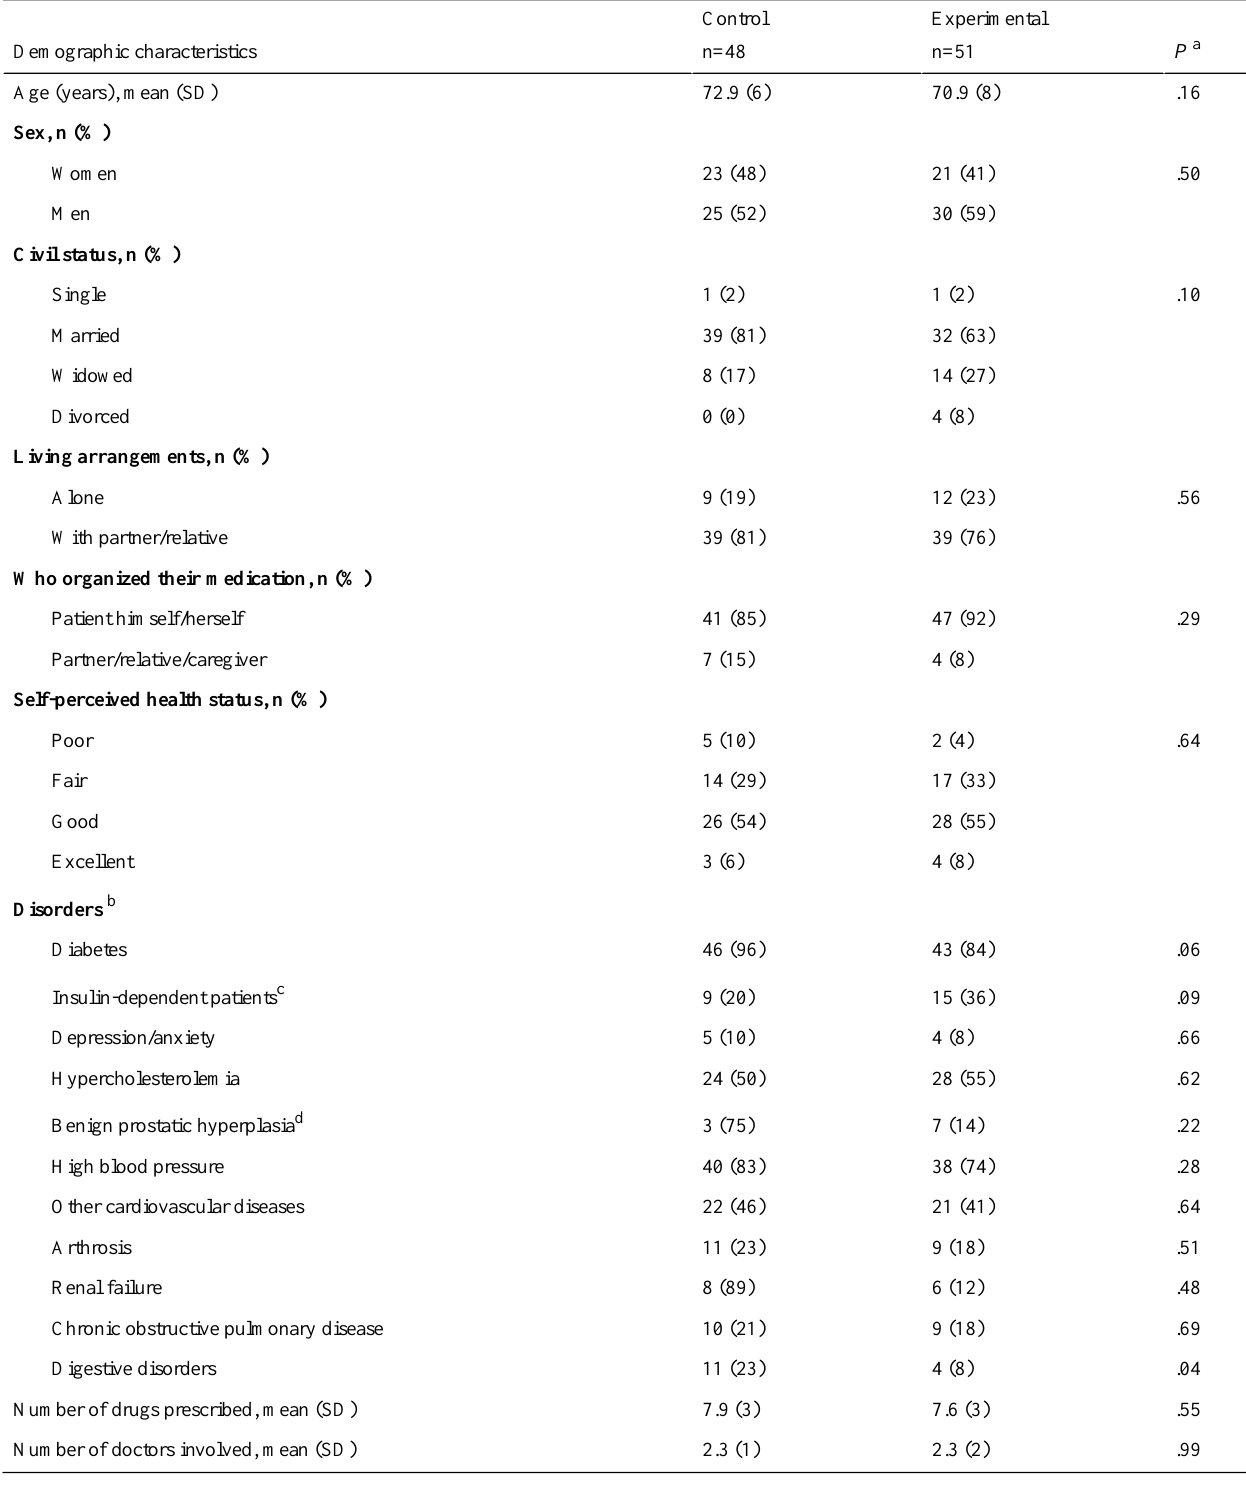
Table 1. Description of patients in the experimental and control groups